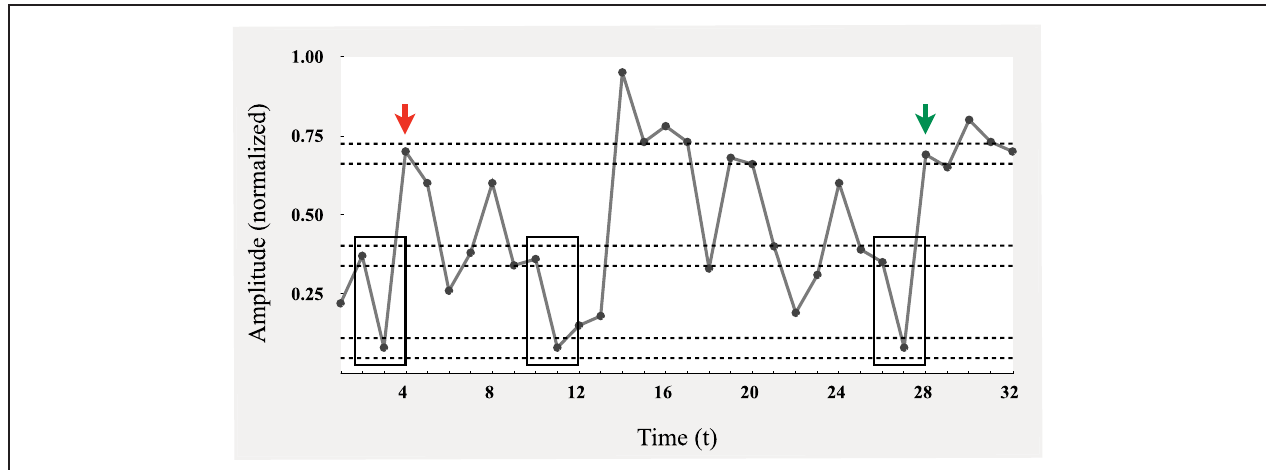
FIGURE 2 | Schematic illustration of the procedure for computing sample entropy [adapted from Costa et al. (2005)].